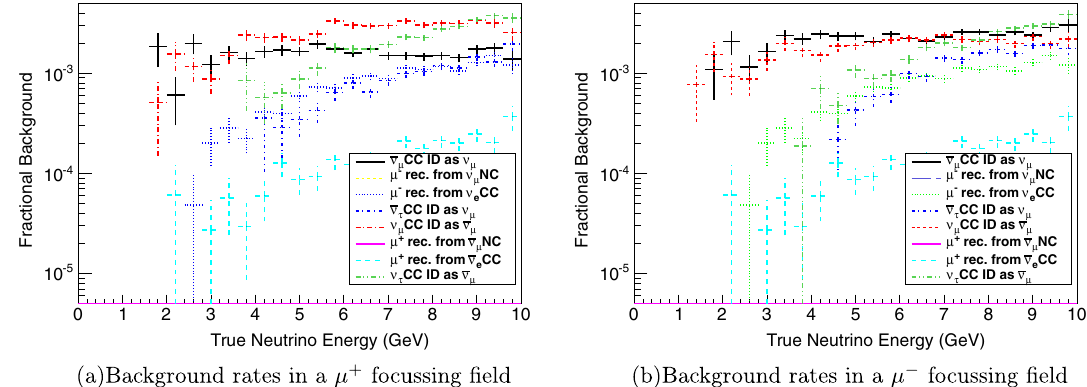
FIG. 10. Background rates for (cid:3) (cid:4) and (cid:2) (cid:3) (cid:4) charge current detection assuming the two different magnetic field configurations.